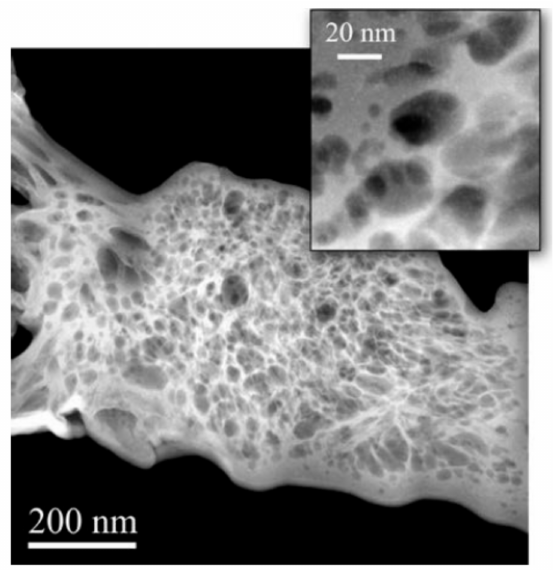
Figure 17. TEM image of the pore network in the C–S–H. Reproduced from [150], with permission from Elsevier,